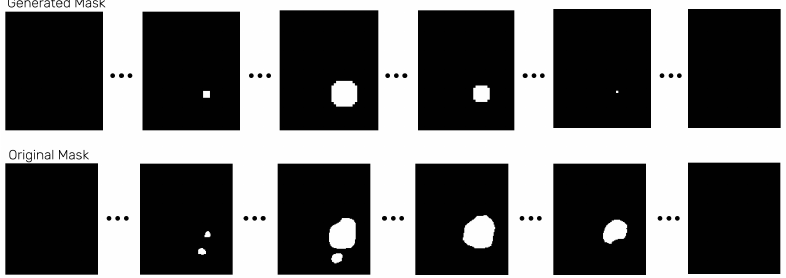
Figure 6. Comparison between the synthetic and an original mask across several channels.